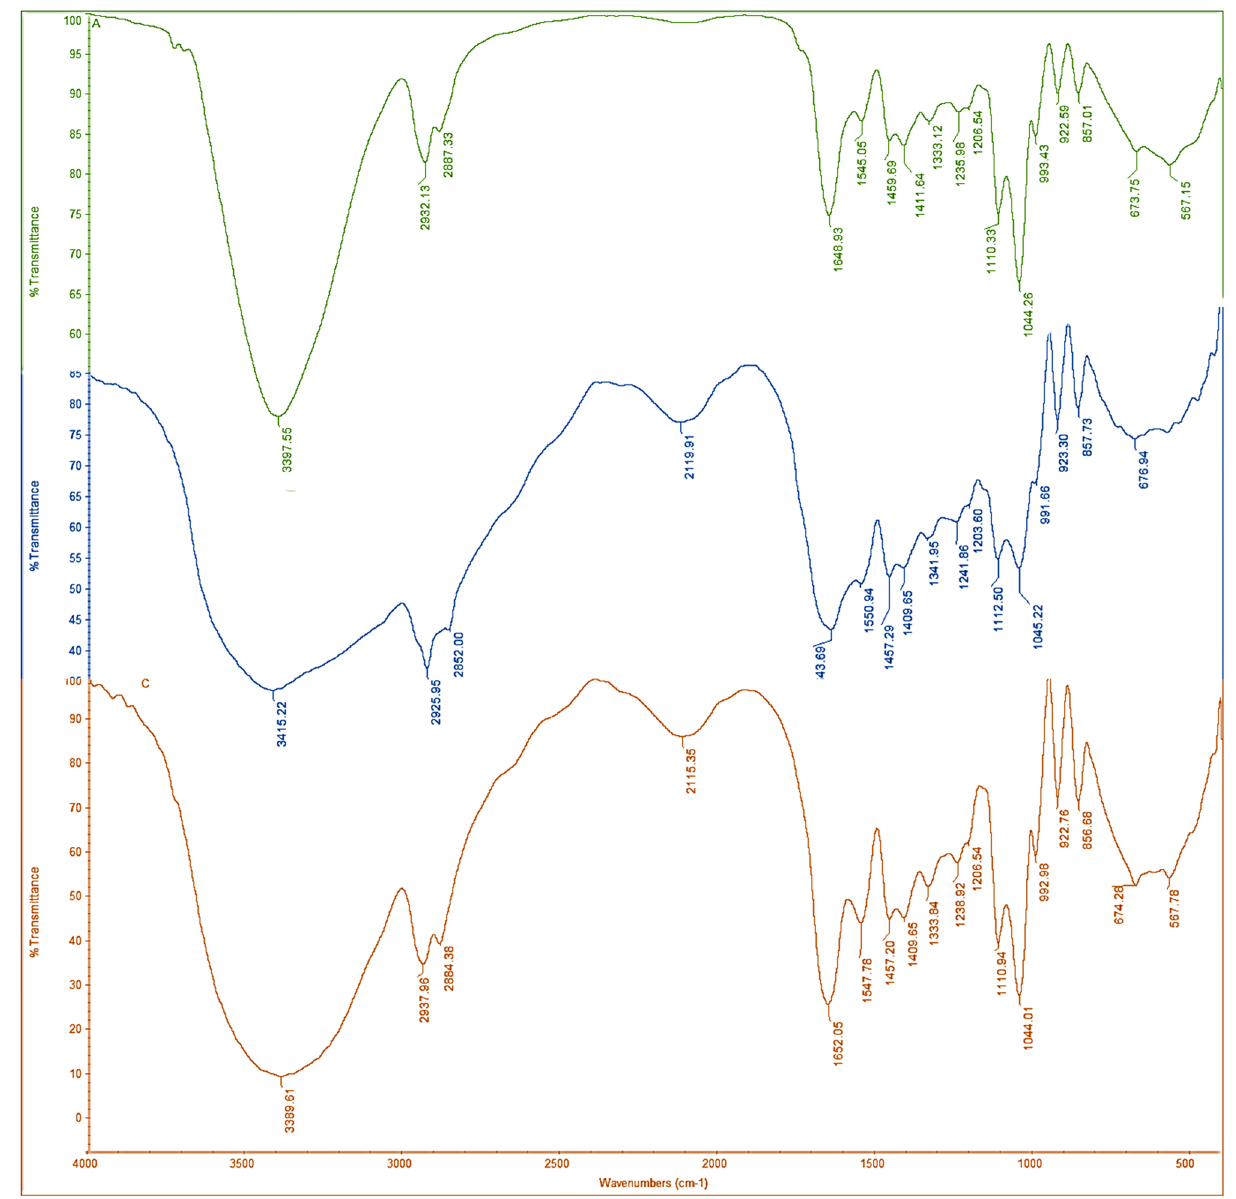
Figure 3. Fourier Transform Infrared Spectroscopy (FTIR) results of sample A-Green color, sample- B-Blue color, and sample C-Maroon color.